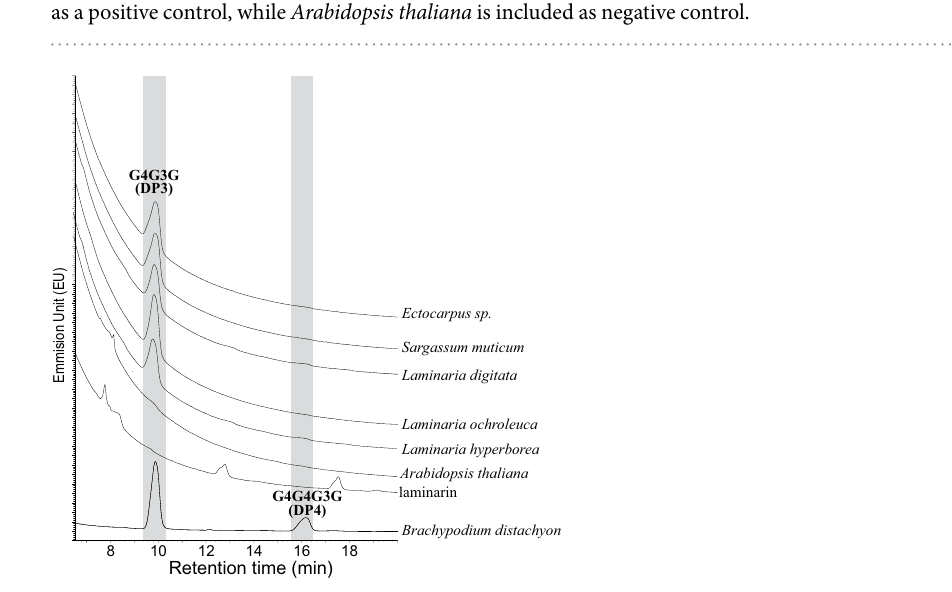
Figure 3. UPLC analysis of lichenase oligomers. Ultra-Performance Liquid Chromatography (UPLC) analysis of the oligosaccharide products released by the lichenase digestion of cell wall extracts obtained from 6 brown algae belonging to 3 distinct orders (Ectocarpales, Fucales, Laminariales). Brachypodium dystachion is included as a positive control, while Arabidopsis thaliana and a commercial laminarin sample are included as negative controls. The chromatogram shows the relative abundance of the tri- (G4G3G) and tetra-saccharides (G4G4G3G). Note that the algal MLG has a very regular structure with trisaccharides only, in contrast to B . dystachion which has both tri- and tetrasaccharide